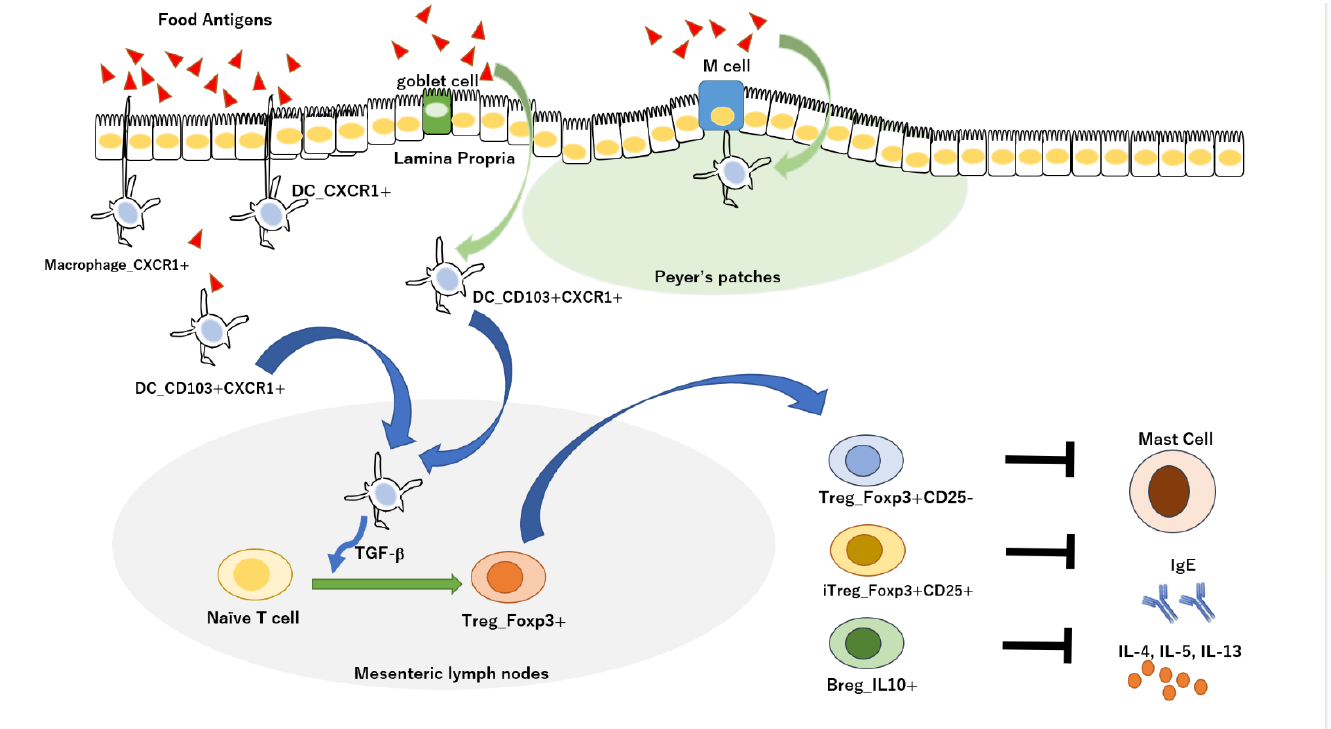
Figure 2. Oral tolerance and intestinal immunity to food antigens. In the intestinal immune system, there is a mechanism “oral immune tolerance” that prevents excessive immune response to foreign foods, and those who break through or avoid it cause allergies. Intestinal dendritic cells induce regulatory T (Treg) cells with immunosuppressive potential. In particular, it has a high ability to induce Treg cells that express Foxp3 in mesenteric lymph node dendritic cells (DCs). Among DCs, CD103+DCs have particularly high ability to induce Foxp3+Treg cells. Macrophages receive antigen and pass it on to CD103+DCs.